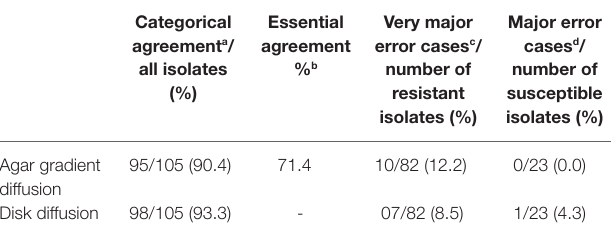
TABLE 3 | Agreement and error rates in mecillinam susceptibility testing compared to the reference method agar dilution. Categorical agreement a /